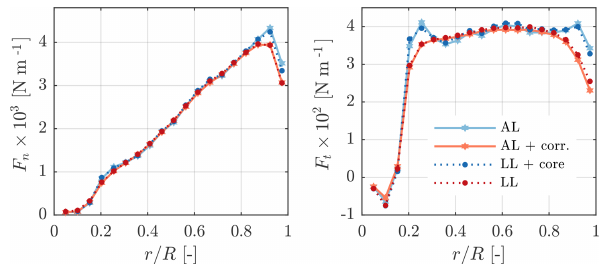
Figure 9. Normal and tangential forces on the NREL 5-MW blades at 8ms − 1 predicted by AL simulations with/without smearing cor- rection and LL with/without viscous core ( N s = 19, (cid:15) = 0 . 1 R ).